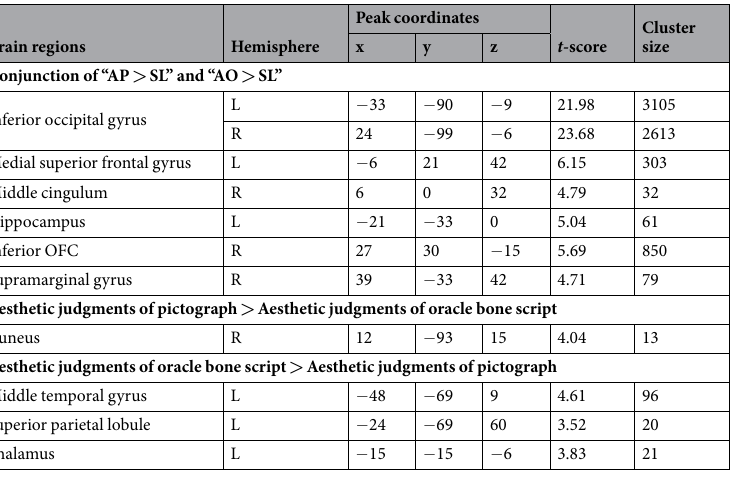
Table 7. Cortical networks of the analysis of conjunction, and the analysis of variance between pictographs and oracle bone scripts regardless of the aesthetic valence. Note: Coordinates refer to the stereotactic space of the Montreal Neurological Institute. The statistical significance refers to p < 0.001 at voxel level (uncorrected), p < 0.05 at cluster level (FWE